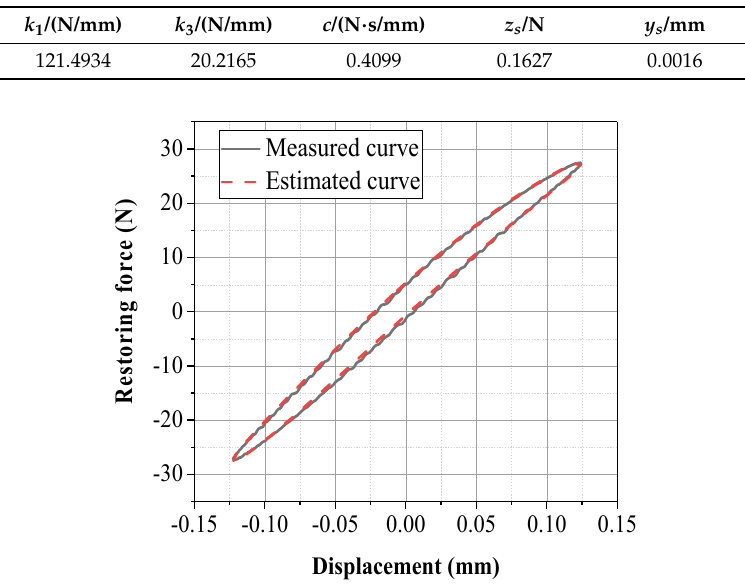
Figure 11. Comparison between the measured curve and estimated curve (vibration amplitude = 0.125 mm, frequency = 5 Hz).